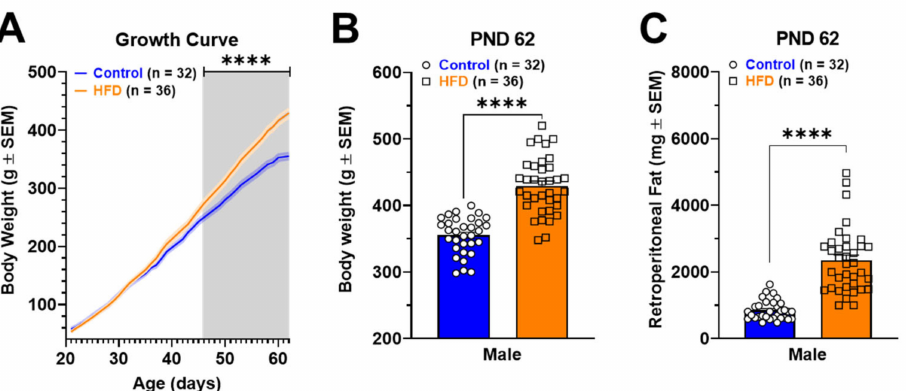
Figure 1. Effects of exposure to HFD from postnatal day (PND) 21 to 62 in male rats. Panel A shows the growth curve during six weeks of male control and HFD rats. Panels B and C show the body weight and retroperitoneal fat pad at the end of the experiments (PND 62). The statistical analysis was a two-way ANOVA multiple comparisons test ( A ) and unpaired t -test ( B , C ) (**** p <